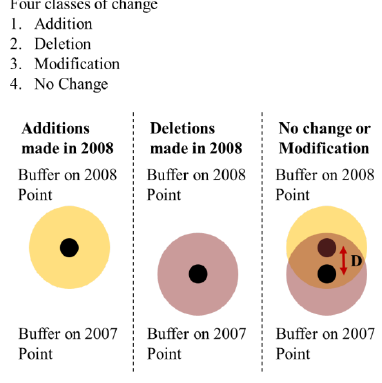
Figure 1 Determination of change in point geometry (e.g., location) between two